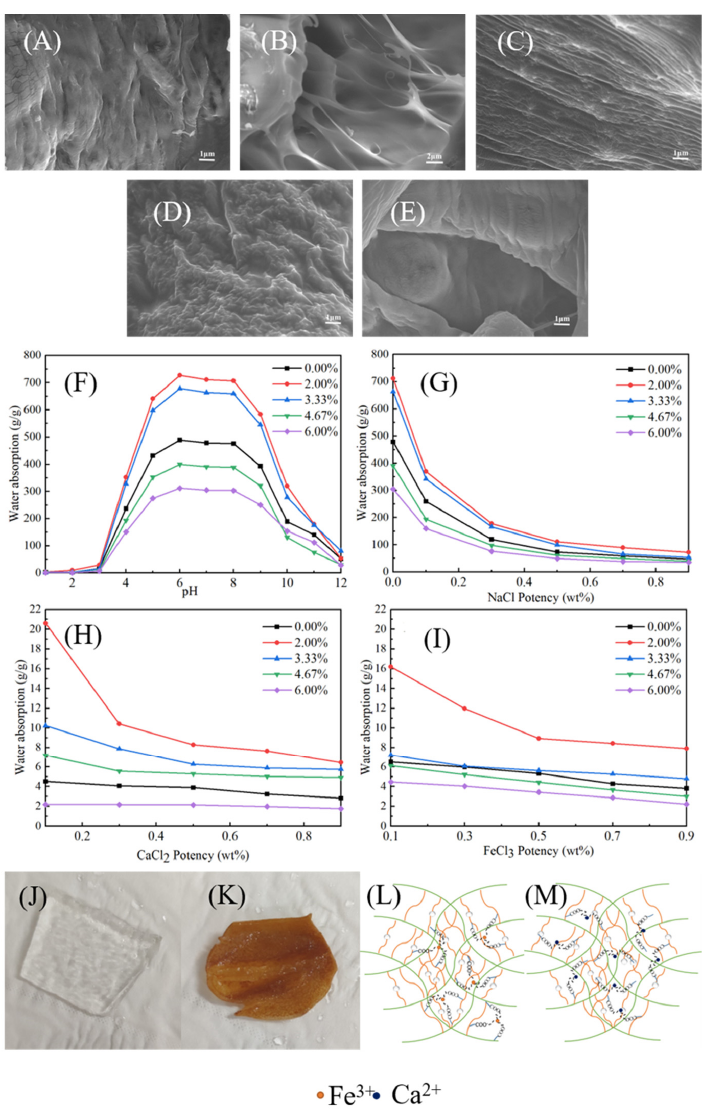
Figure 11. SEM images of CAAMC without MNC ( A ) and with 2 wt% MNC ( B ), 3.33 wt% MNC ( C ), 4.67 wt% MNC ( D ), and 6 wt% MNC ( E ); effects of solution pH on the water absorbency of CAAMC with different modified calcium carbonate contents ( F ), the water absorbency of CAAMC with different MNC contents in NaCl ( G ), CaCl 2 ( H ), and FeCl 3 ( I ) aqueous solutions; appearance of CAAMC after swelling equilibrium in deionized water ( J ) and the FeCl 3 solution ( K ); structural models of CAAMC at salt solutions FeCl 3 ( L ) and CaCl 2 ( M ).